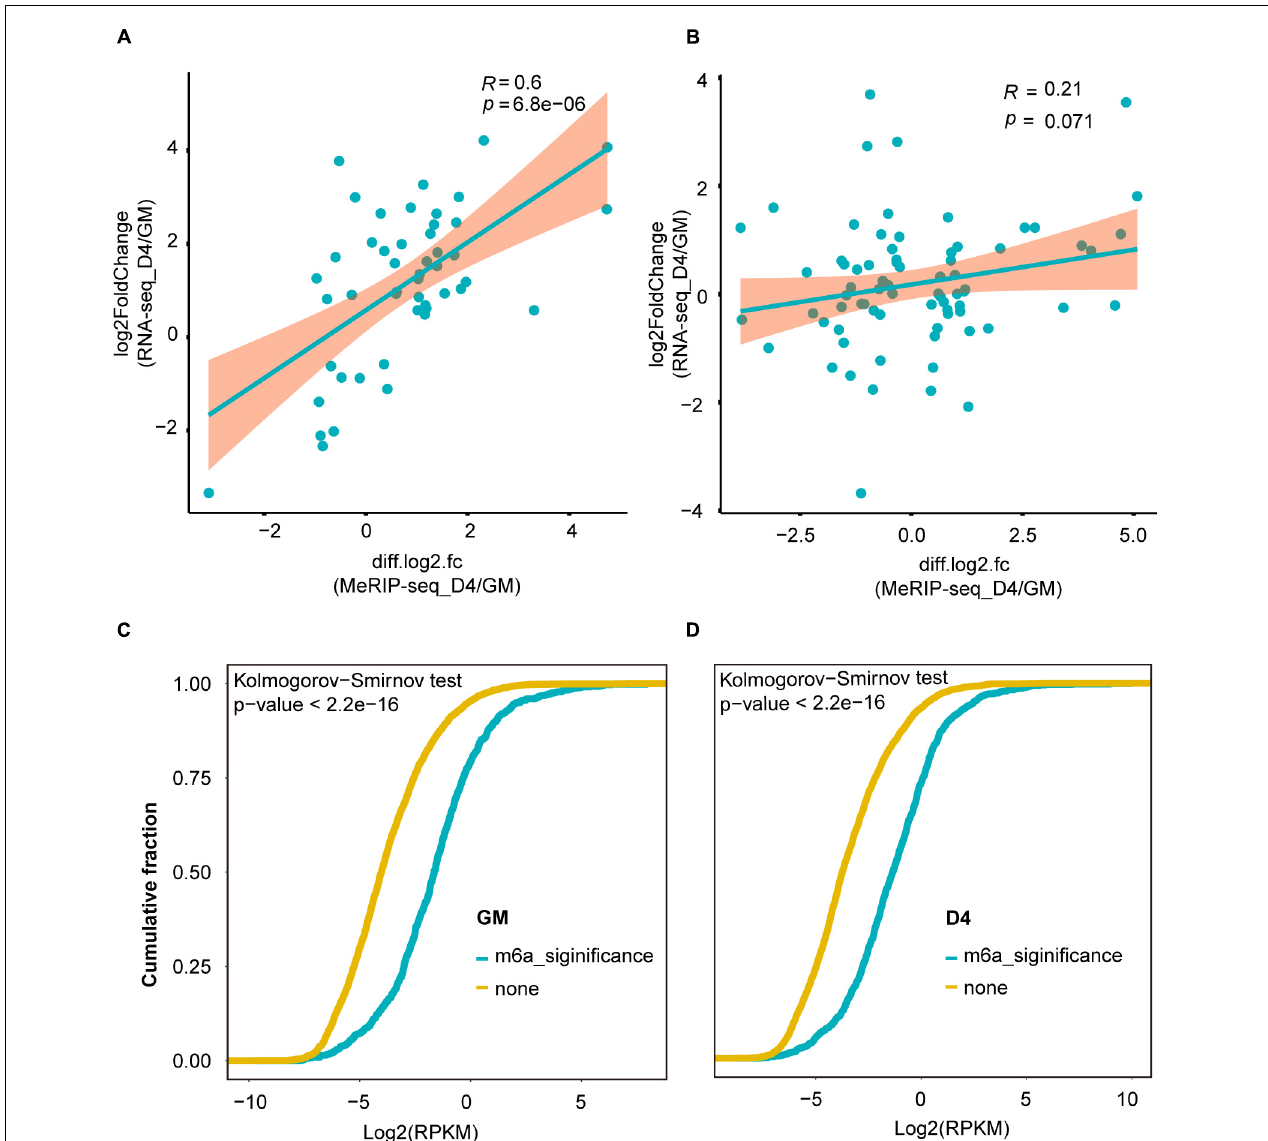
FIGURE 4 | m 6 A methylation levels were positively correlated with the abundance of lncRNAs. (A) Scatter plot shows the positive correlation between m 6 A levels (significant changes) and expression values of lncRNAs with significantly differential expression between GM and D4, adjusted P ≤ 0.05. (B) Scatter plot shows no correlation between m 6 A levels (no significant changes) and expression values of lncRNAs without significantly differential expression between GM and D4. (C) Cumulative frequency of log2FC for lncRNAs containing m 6 A or without m 6 A methylation in GM. Kolmogorov-Smirnov test was used to estimated inter-group difference. (D) Cumulative frequency of log2FC for lncRNAs containing m 6 A or without m 6 A methylation in D4. Kolmogorov-Smirnov test was used to estimated inter-group difference.